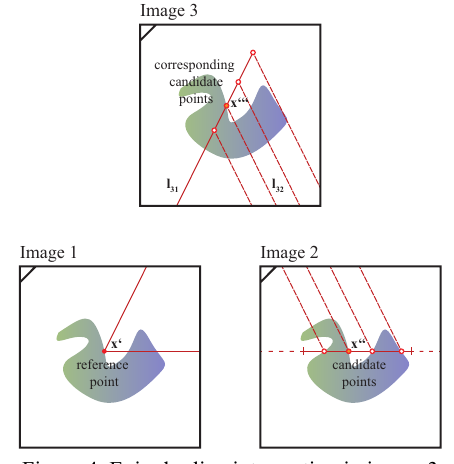
Figure 4. Epipolar line intersection in image